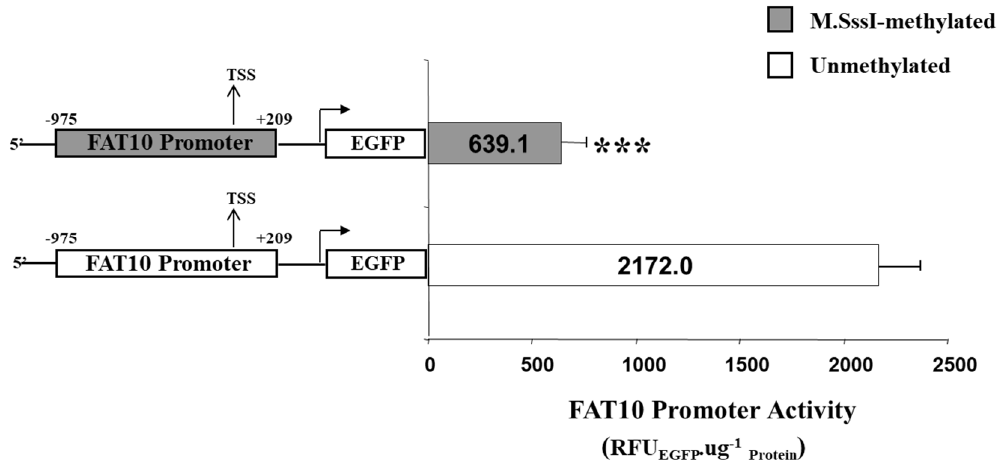
Figure 6. Activity of the FAT10 promoter that has been methylated in vitro versus the promoter that has not been methylated. The FAT10 promoter that has either been methylated with M.SssI or mock methylated (unmethylated) is fused with the enhanced green fluorescent protein (EGFP) reporter protein and transfected into Hep3B cells. The FAT10 promoter activity expressed through EGFP protein levels is determined. Figure shows the mean and standard error from four (methylated) and five (unmethylated) independent experiments. *** denotes a significant difference ( p < 0.001) in activity between the unmethylated and methylated FAT10 promoter.